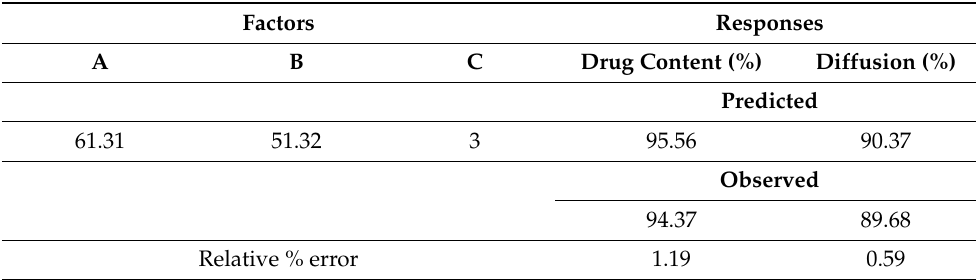
Table 9. Selected solution and % error between the predicted and the observed